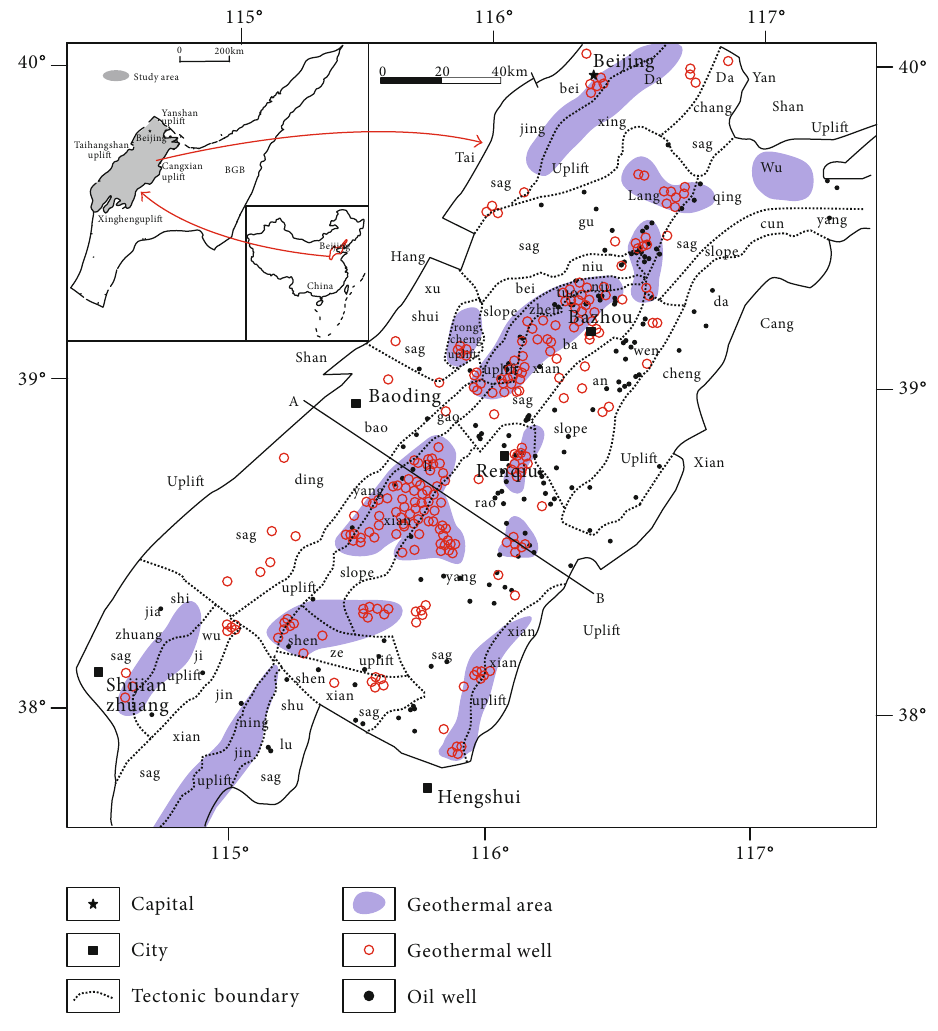
Figure 1: Sketch map showing the structure and geothermal area of the Jizhong